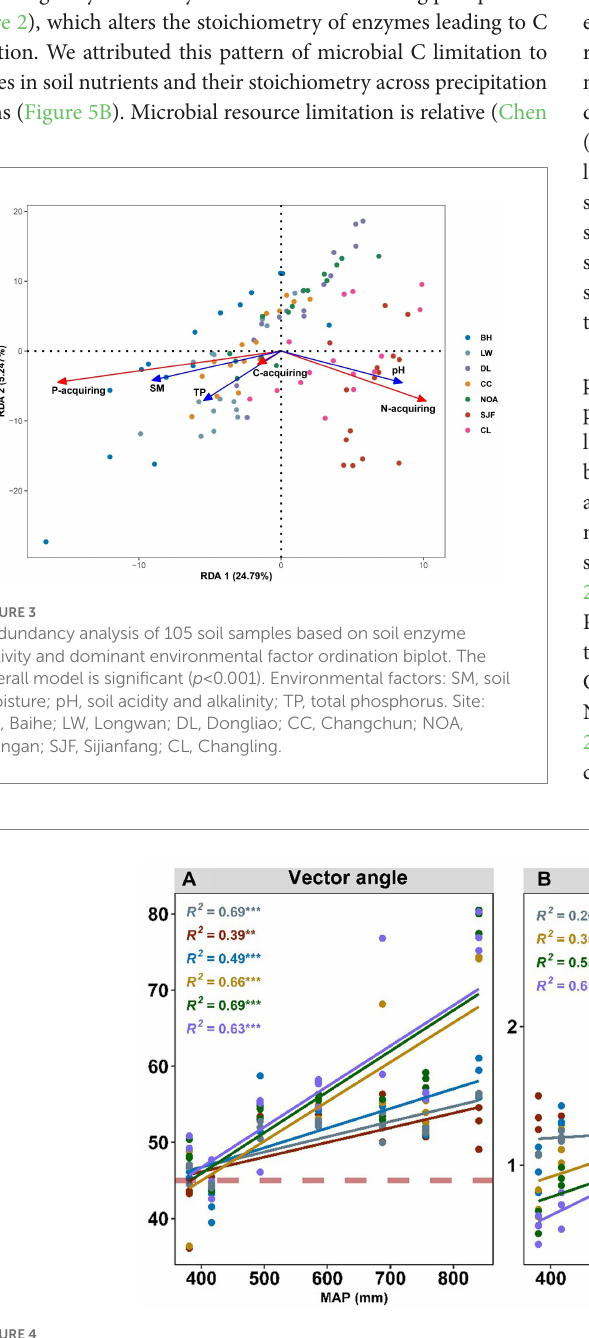
FIGURE 4 Effects of MAP (mm) on microbial N/P limitation (A) and microbial C limitation (B) . Soil microbial N/P limitation is represented by vector angles: >45 ° represents P limitation, and < 45 ° represents N limitation. Soil microbial C limitation is represented by vector lengths, where microbial C limitation increases as the values increase. MAP represents mean annual